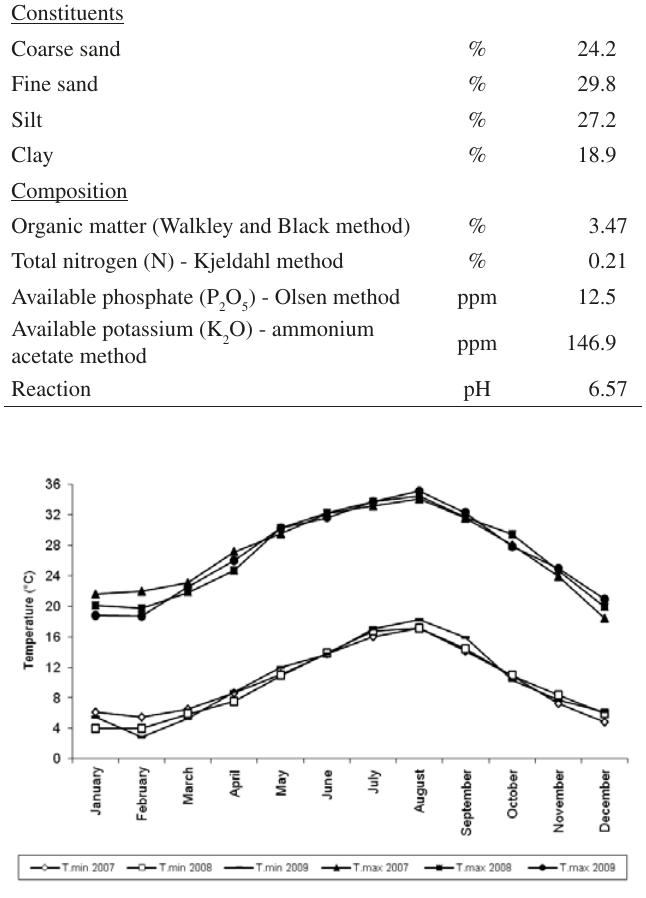
Fig. 1 - Trend of monthly temperatures in